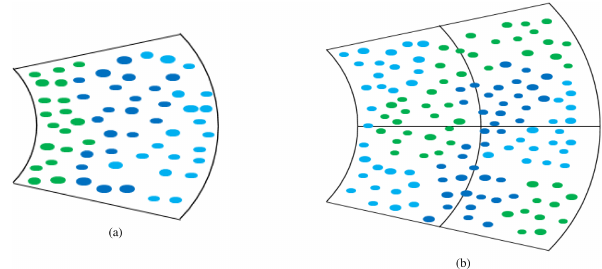
Figure 1. Simplified schematic representation of (a) bin-based de- mixing and (b) neighborhood-based analysis. In reality, the spatial organization of mixed hydrometeor types is presumed to be signifi- cantly more